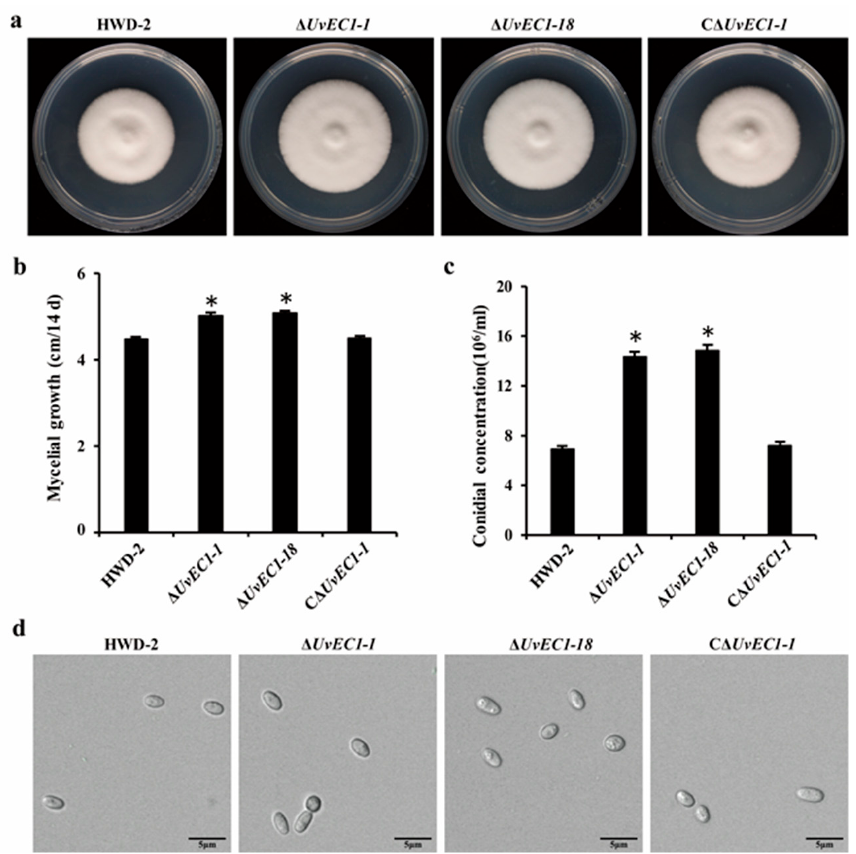
Figure 3. Deletion of UvEC1 affects vegetative growth and conidiation of U. virens . ( a ) Colony morphology of the wild type HWD-2, ∆ UvEC1 mutants and the complementation strain on potato sucrose agar (PSA) medium after 14 days of growth in the dark at 28 °C. ( b ) Mean colony diameter of the strains shown in a. ( c ) Mean conidial production of the wild type HWD-2, the ∆ UvEC1 mutants and complementation strain grown in potato sucrose broth (PSB) medium at 28 °C with shaking at 180 rpm for 7 days. ( d ) Conidia morphology of the wild type HWD-2, the ∆ UvEC1 mutants and complementation strain. Scale bar = 5 μ m. Asterisks represent significant differences relative to HWD-2, as determined by Least Significant Difference (LSD) at p = 0.05.